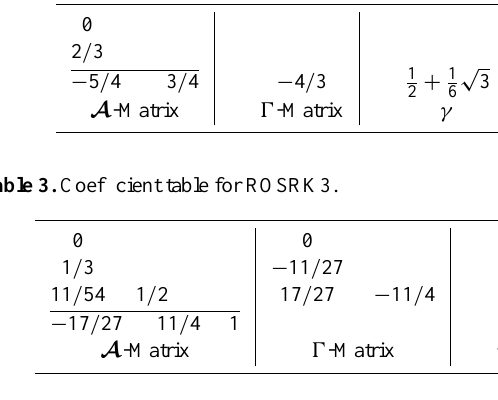
Table 2. Coefficient table for ROS2.